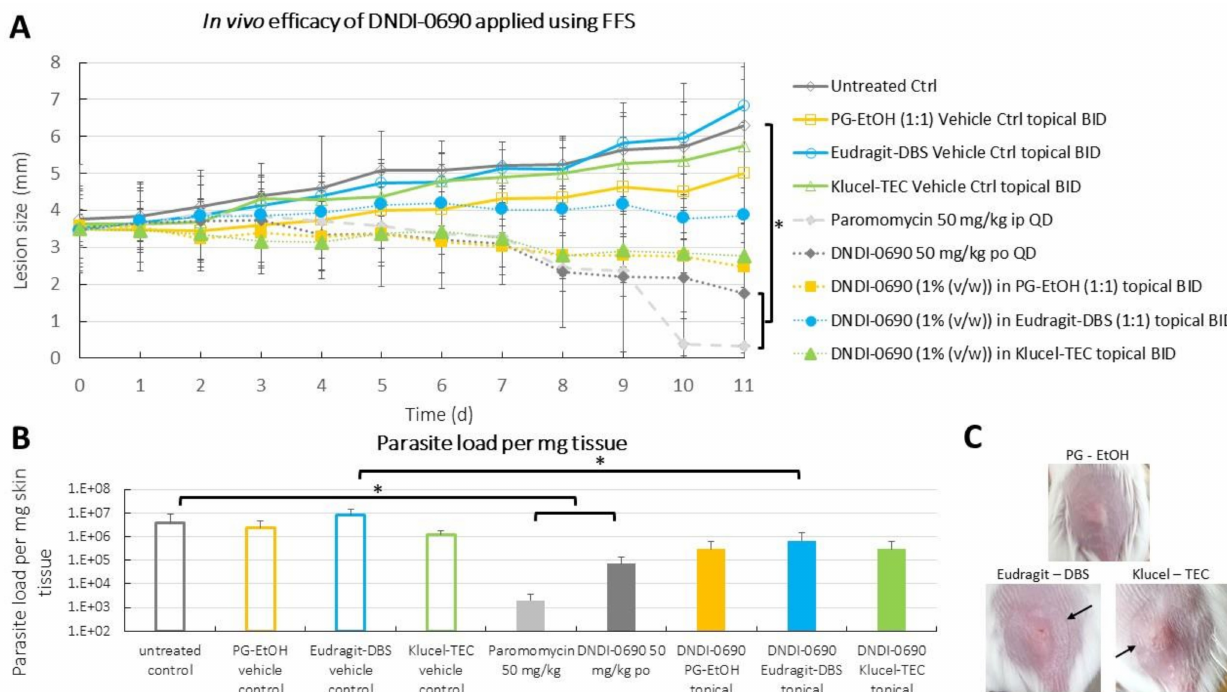
Figure 3. The in vivo efficacy of DNDI-0690 FFS formulations in an experimental model of cutaneous leishmaniasis (CL). ( A ) The skin lesion sizes of Leishmania -infected mice were measured daily throughout the treatment that started on day 1 and terminated on day 11. This graph shows the lesion size (mm) in function of time ( n = 4, average ± SD) (* p < 0.05, repeated-measures ANOVA, post-hoc Tukey test, SPSSv26) (po, per os; ip, intraperitoneally; BID, twice daily; QD, once daily). ( B ) The average parasite load (analysed by qPCR) in the CL lesions per treatment group ( n = 4, average ± SD) (* p < 0.05, one-way ANOVA, post-hoc Tukey test, SPSS v26). ( C ) The DNDI-0690 containing Eudragit–DBS and Klucel–TEC film (bottom panel, black arrow indicates the edge of each film) and the DNDI-0690 in PG–EtOH suspension (top) upon application on the Leishmania -infected BALB/c mouse